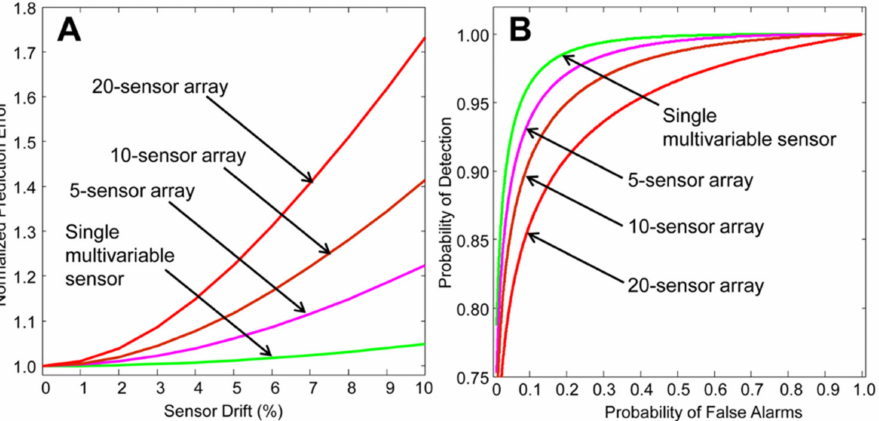
Figure 9. ( A ) Demonstration of the sensor prediction rate error increase with increasing sensor drift for the comparison of arrays and multivariate sensors. ( B ) Probability of detection against false alarm predictions for multivariable sensors against sensor arrays. Figure from